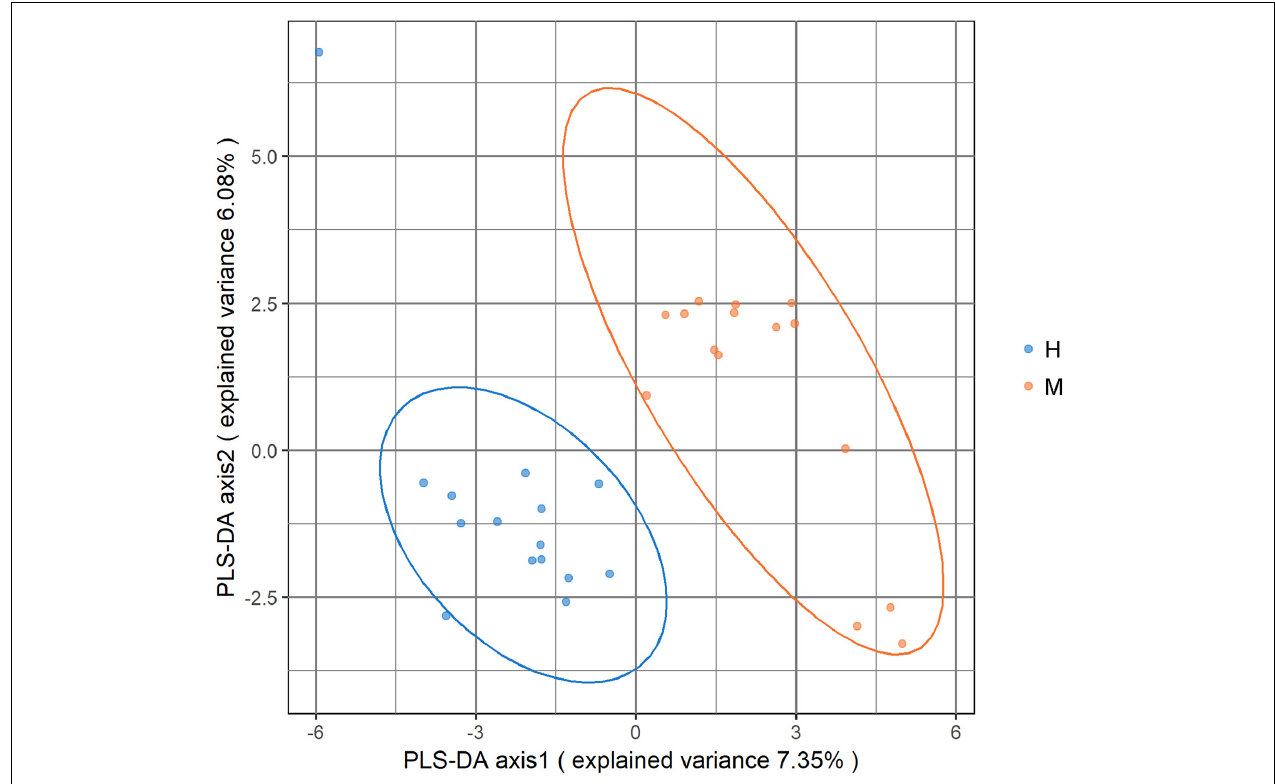
FIGURE 2 | Score plot of partial least square-discriminant analysis (PLS-DA) showed that the MSA and healthy groups were separated into two clusters. Each dot represented one sample.